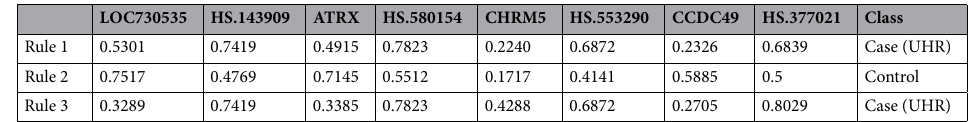
Table 2. Example rule from the LYRIKS dataset. Example of personalised classification rules (in symbolic form) from a randomly selected sample in the LYRIKS dataset. The columns represent the antecedents of each rule. Antecedents are expressed by ‘about’ terms, e.g., Rule 1: IF (LOC730535 is about 0.5301) AND … AND (HS.377021 is about 0.6839) THEN Class is Case, etc.